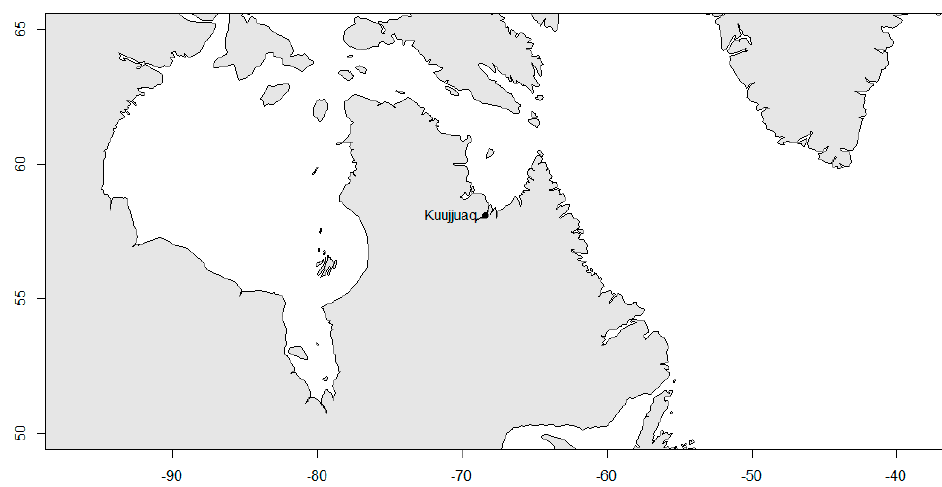
Figure 1. Site location: Kuujjuaq, Quebec (58°05 ′ 42 ′ ’ N, 68°25 ′ 20 ′ ’ W).